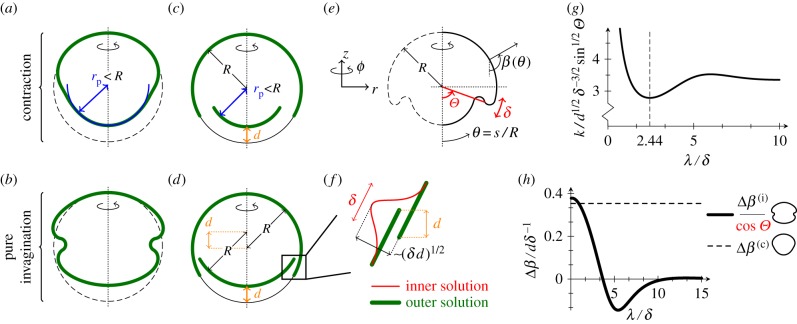
Asymptotic analysis of invagination and contraction. (a) Numerical shape resulting from contracting the posterior to a radius rp < R. (b) Numerical ‘hourglass’ shape resulting from pure invagination. (c) Geometry of contraction with posterior radius rp < R, resulting in upward motion of the posterior by a distance d. (d) Geometry of pure invagination solution. (e) Asymptotic geometry: in the limit  deformations are localized to an asymptotic inner layer of width δ about θ = Θ, where θ = s/R is the angle that the undeformed normal makes with the vertical. In the deformed configuration, this angle has changed to β(θ). (f) Asymptotic invagination: upward motion of the posterior by a distance d requires inward deformations scaling as (δd)1/2 in the inner layer of width δ. (g) Relation between preferred curvature k and width of invagination λ for a given amount of upward posterior motion d, from asymptotic calculations. (h) Inward rotation Δβ of the midpoint of the invagination with, and without contraction, from asymptotic calculations.